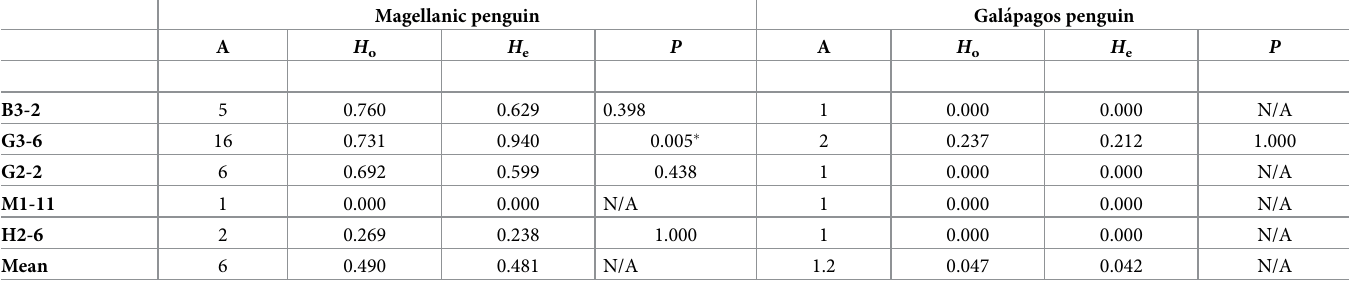
Table 5. Summary of microsatellite data for Magellanic and Gala´pagos penguins. Number of alleles (A), observed heterozygosity ( H o ), expected heterozygosity ( H e ), and Hardy-Weinberg equilibrium P -values ( P ) for each locus analyzed are presented. N/A indicates no test was performed because the locus was monomorphic. Magellanic